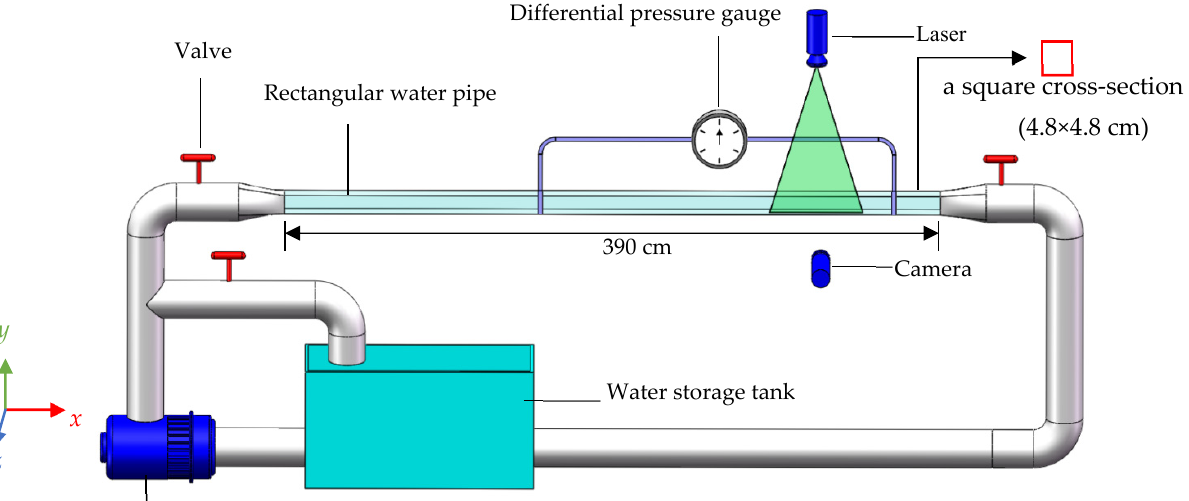
Figure 3. Diagram of experimental circulation pipes.